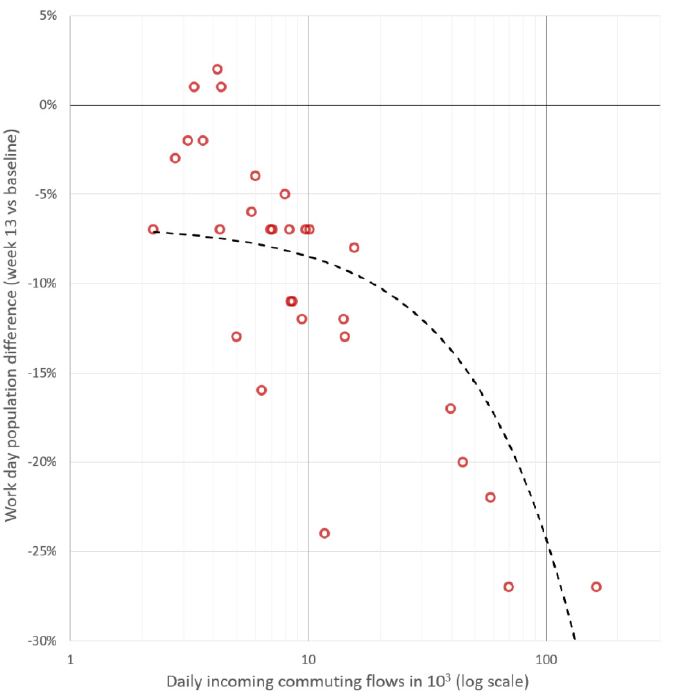
Figure 4. The correlation between daily incoming commuting flows (per 1000 commuters, log scale) and the change in workday presence of people from the baseline in case of the 30 largest municipalities in Finland.